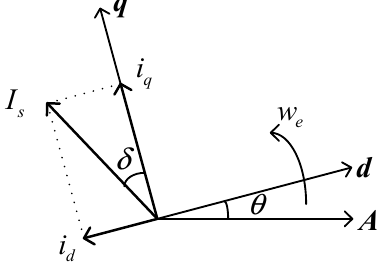
Figure 5. Space diagram of current vector angle.